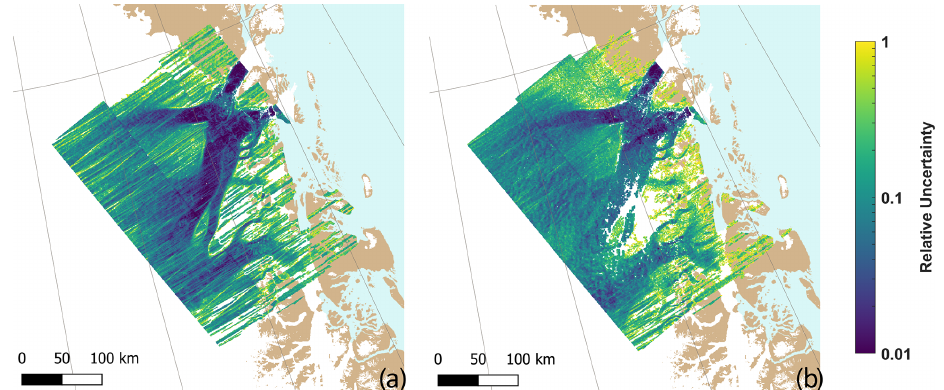
Figure 8. Relative horizontal velocity error estimates for the single-pair velocity maps in Fig. 7: (a) 6d pair acquired on 11 and 17 October 2016 and (b) 12d pair acquired on 11 and 23 October 2016.